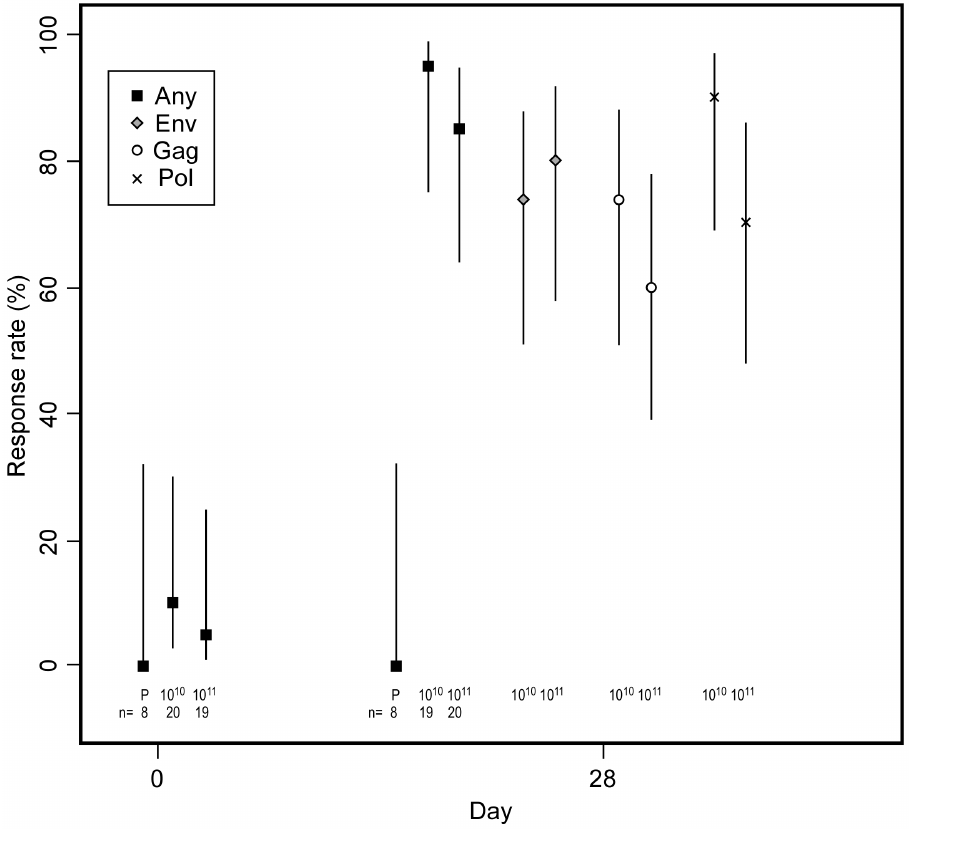
Figure 5. T-cell responses to HIV antigens by ICS. Points indicate percentage of participants with positive responses (for CD4 + or CD8 + T cell subsets, and for IFN- c or IL-2 detection); n denotes the number in each group with ICS data. Lines indicate 95% confidence intervals.